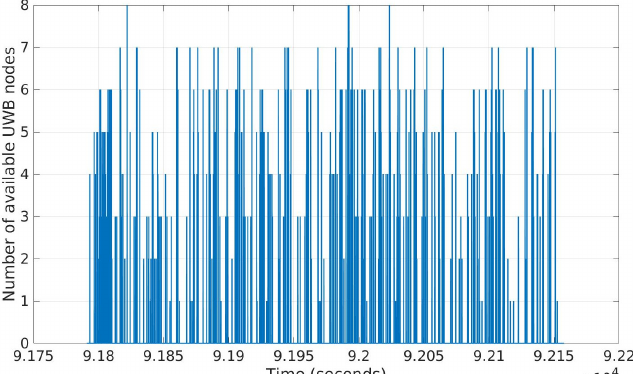
Figure 10. Number of communicating UWBs available to UAV 103 during the experiment.